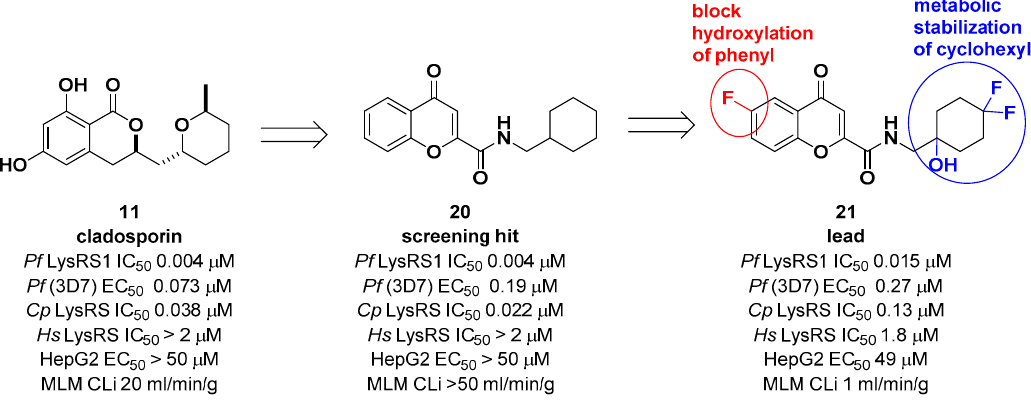
Figure 6. Optimization of cladosporin by replacing the core with a chromone scaffold.